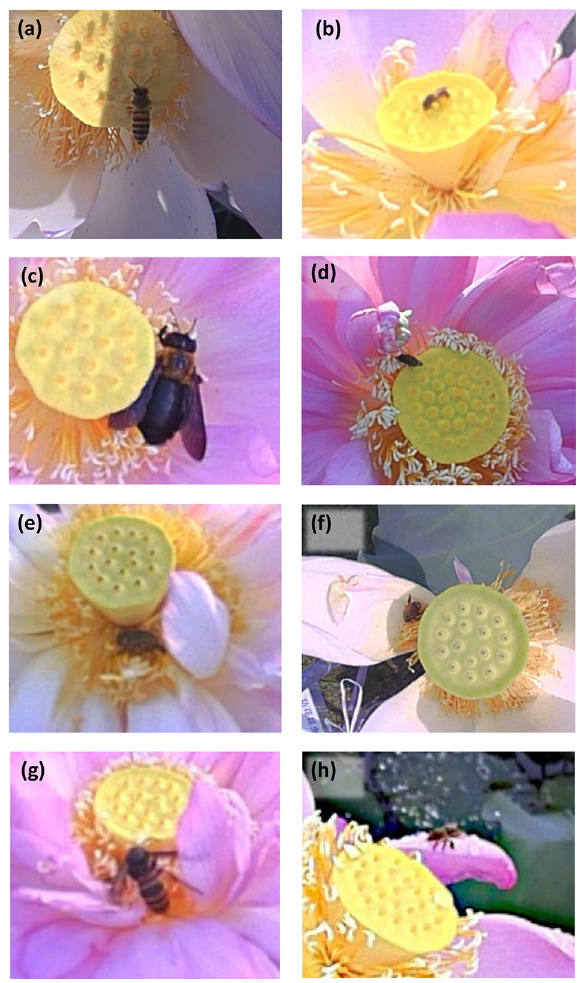
Figure 1. Examples of photos of arthropods visiting lotus flowers taken in the field of this study: ( a ) honeybee, ( b ) Halictidae sp., ( c ) Xylocopa appendiculata circumvolans , ( d ) Stomorhina obsoleta , ( e ) Gametis jucunda , ( f ) Popillia japonica , ( g ) Vespa analis insularis , and ( h )